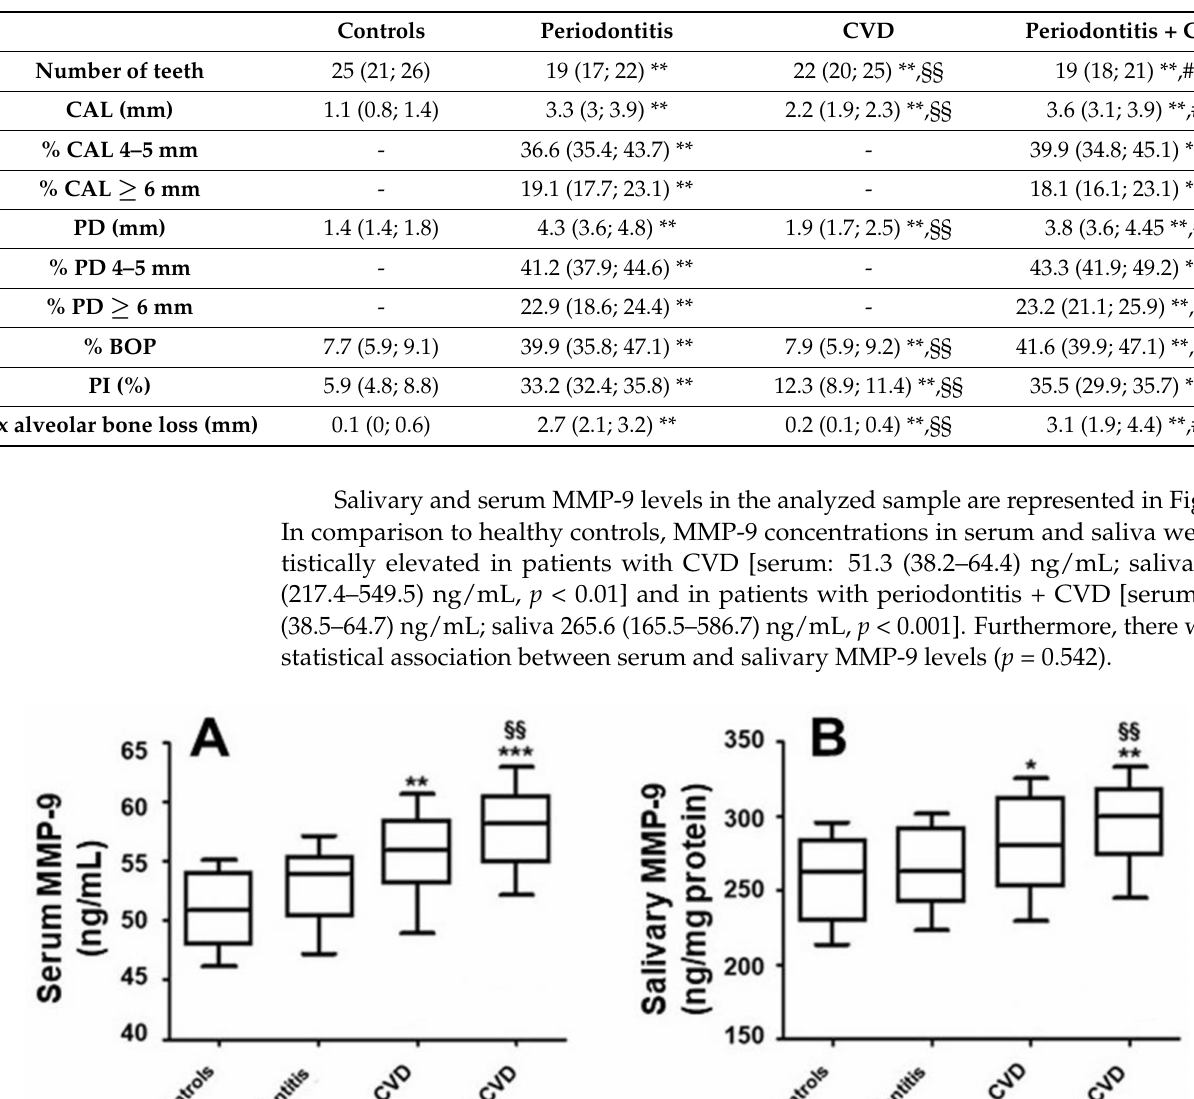
Table 2. Median (25th; 75th percentile) values of the periodontal characteristics of the analyzed patients. CAL, clinical attachment level; PD, probing pocket depth; BOP, bleeding on probing; PI, plaque index. ** p < 0.001 differences vs. healthy patients. ## p < 0.001 differences vs. CVD patients. §§ p < 0.001 differences vs. periodontitis patients.